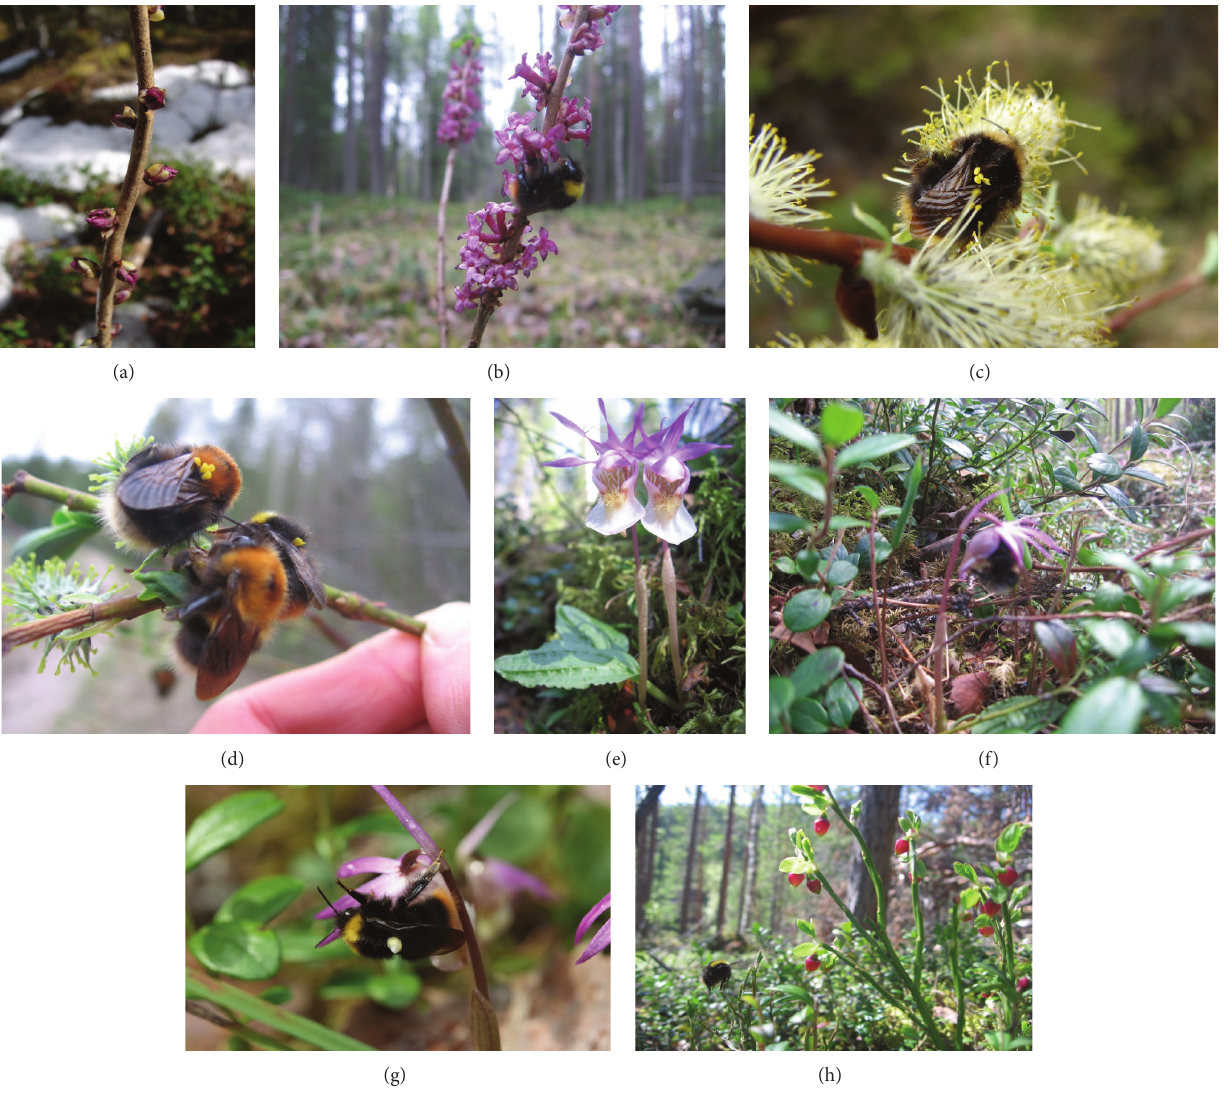
Figure 1: Calypso bulbosa, its pollinators, and coflowering species; (a) flowers of Daphne mezereum at a forest site, still with melting snow (May 2008, JT); (b) slowly moving Bombus pratorum on flowering D. mezereum at a forest site (May 2007, LW); (c) B. pratorum with several pairs of Calypso pollinia on willow (May 2008, JT); (d) inactive bumblebee queens on willow either with pollinia (behind: B. pratorum with 2 pairs of pollinia; uppermost: B. hypnorum/cingulatus with 5 pairs of pollinia) or without ( B. hypnorum/cingulatus lowest) (June 2007, LW); (e) two flowering C. bulbosa (June 2007, LW); (f) Bombus sp. visiting a Calypso flower (2007, LW); (g) B. pratorum atypically walking on C. bulbosa flower and with a pollinarium covered by a cap (May 2010, TA); and (h) Bombus sp. and Vaccinium myrtillus at the start of flowering (June 2007, LW). Photos by Thomas Abeli (TA), Juha Tuomi (JT), and Lauri Wannas (LW) in the Oulanka National Park, Kuusamo, Finland.